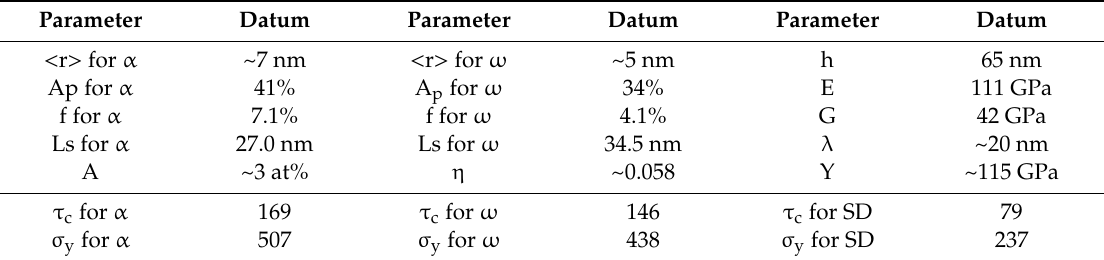
Table 4. Summary of the inserted data and the calculated strengthening contributions. Note that SD represents spinodal